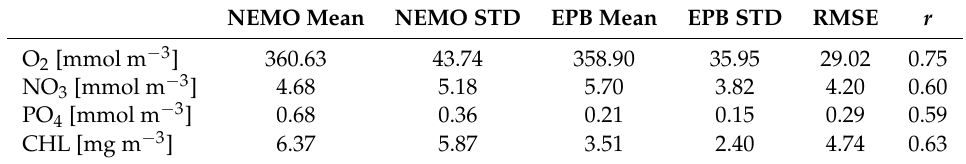
Figure 4. Taylor diagram where the reference point indicate NEMO-SCOBI model data. Table 4. Statistical comparison of EcoPuckBay model with NEMO-SCOBI (Nucleus for European Modelling of the Ocean coupled with Swedish Coastal and Ocean Biogeochemical model) model